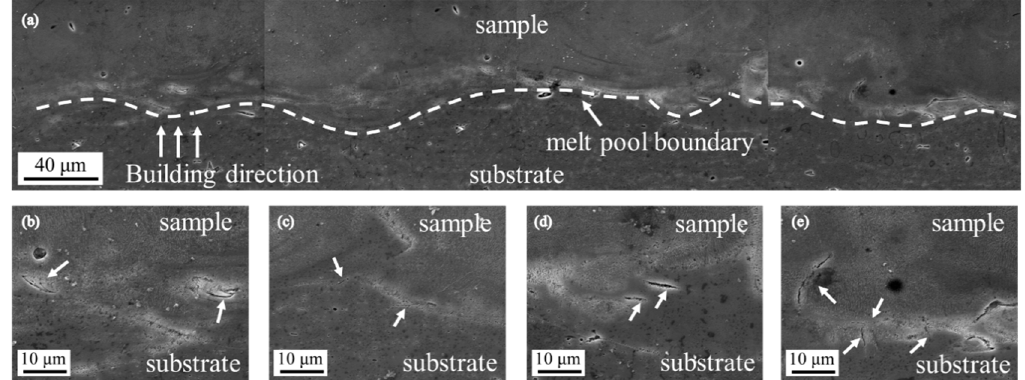
Figure 5. ( a ) SEM observation at the joint between SLM-produced AlSi10Mg samples and building platform. White dashed lines represent melt pool boundaries. ( b – e ) Higher magnification of cracks. White arrows point to cracks.